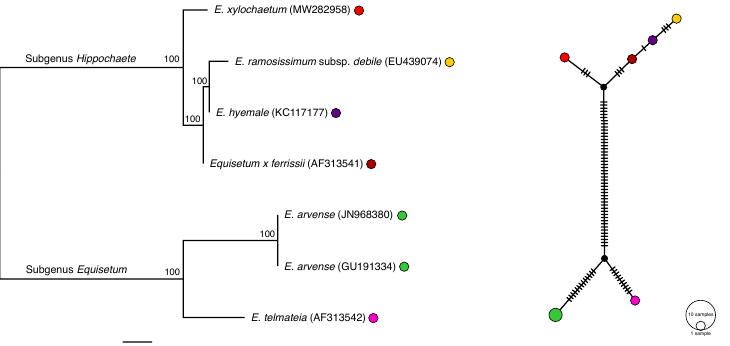
Figure 3. Phylogenetic estimation and TCS network of Equisetum atpB sequences. The scale bar of the tree represents the estimated number of nucleotide substitutions per site. The maximum- likelihood bootstrap values are reported at the respective nodes. The colours of taxa present in the tree correspond with the colours in the TCS haplotype map. The size of the circle represents the number of the taxa that share the same